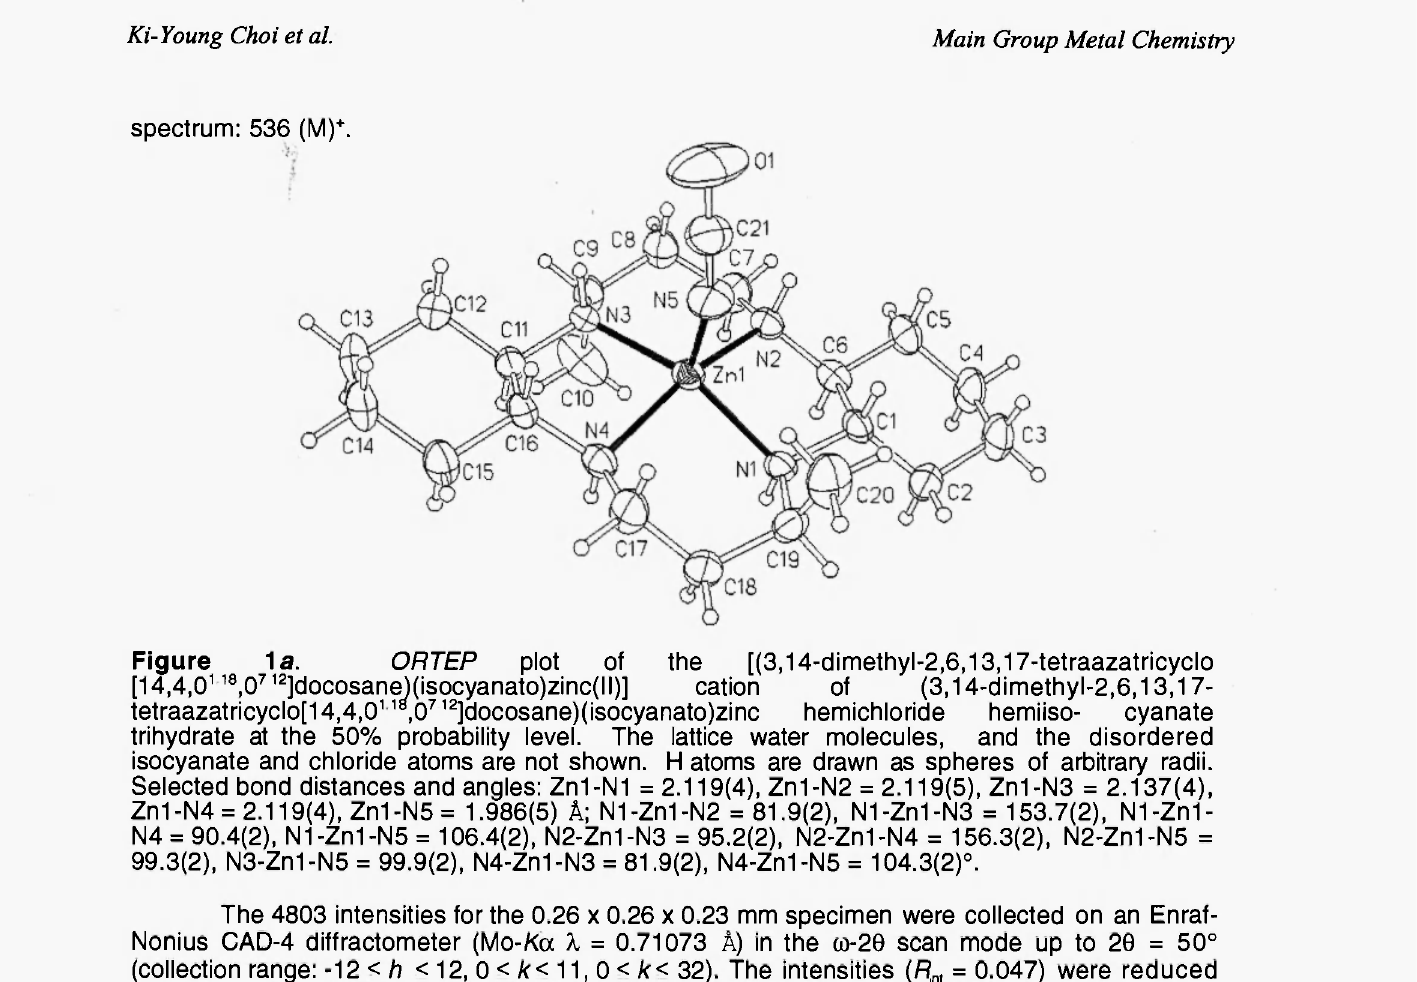
Figure 1a. ORTEP plot of the [(3,14-dimethyl-2,6,13,17-tetraazatricyclo [14,4,0 118 ,0 712 ]docosane)(isocyanato)zinc(ll)] cation of (3,14-dimethyl-2,6,13,17- tetraazatricyclo[14,4,0 11 ®,0 712 ]docosane)(isocyanato)zinc hemichloride hemiiso- cyanate trihydrate at the 50% probability level. The lattice water molecules, and the disordered isocyanate and chloride atoms are not shown. Η atoms are drawn as spheres of arbitrary radii. Selected bond distances and angles: Zn1-N1 = 2.119(4), Zn1-N2 = 2.119(5), Zn1-N3 = 2.137(4), Zn1-N4 = 2.119(4), Zn1-N5 = 1.986(5) A; N1-Zn1-N2 = 81.9(2), N1-Zn1-N3 = 153.7(2), N1-Zn1- N4 = 90.4(2), N1-Zn1-N5 = 106.4(2), N2-Zn1-N3 = 95.2(2), N2-Zn1-N4 = 156.3(2), N2-Zn1-N5 = 99.3(2), N3-Zn1 -N5 = 99.9(2), N4-Zn1 -N3 = 81.9(2), N4-Zn1 -N5 =